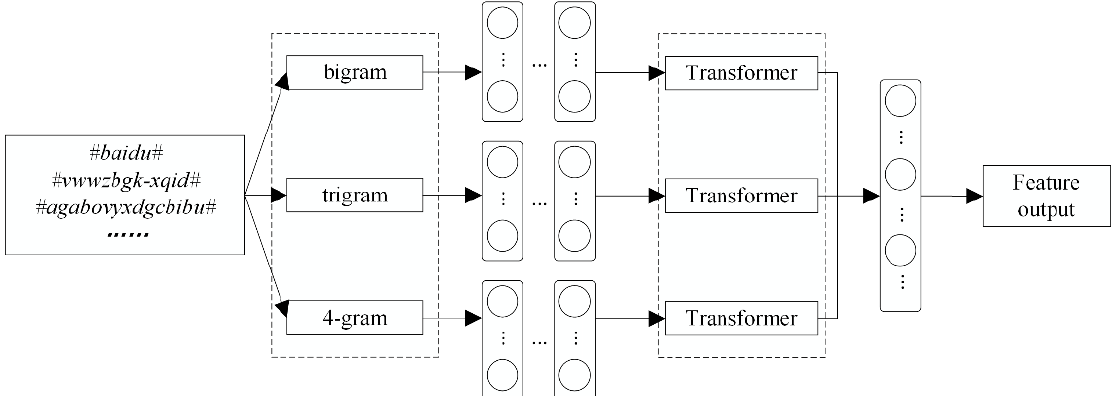
Figure 3. Parallel model structure.